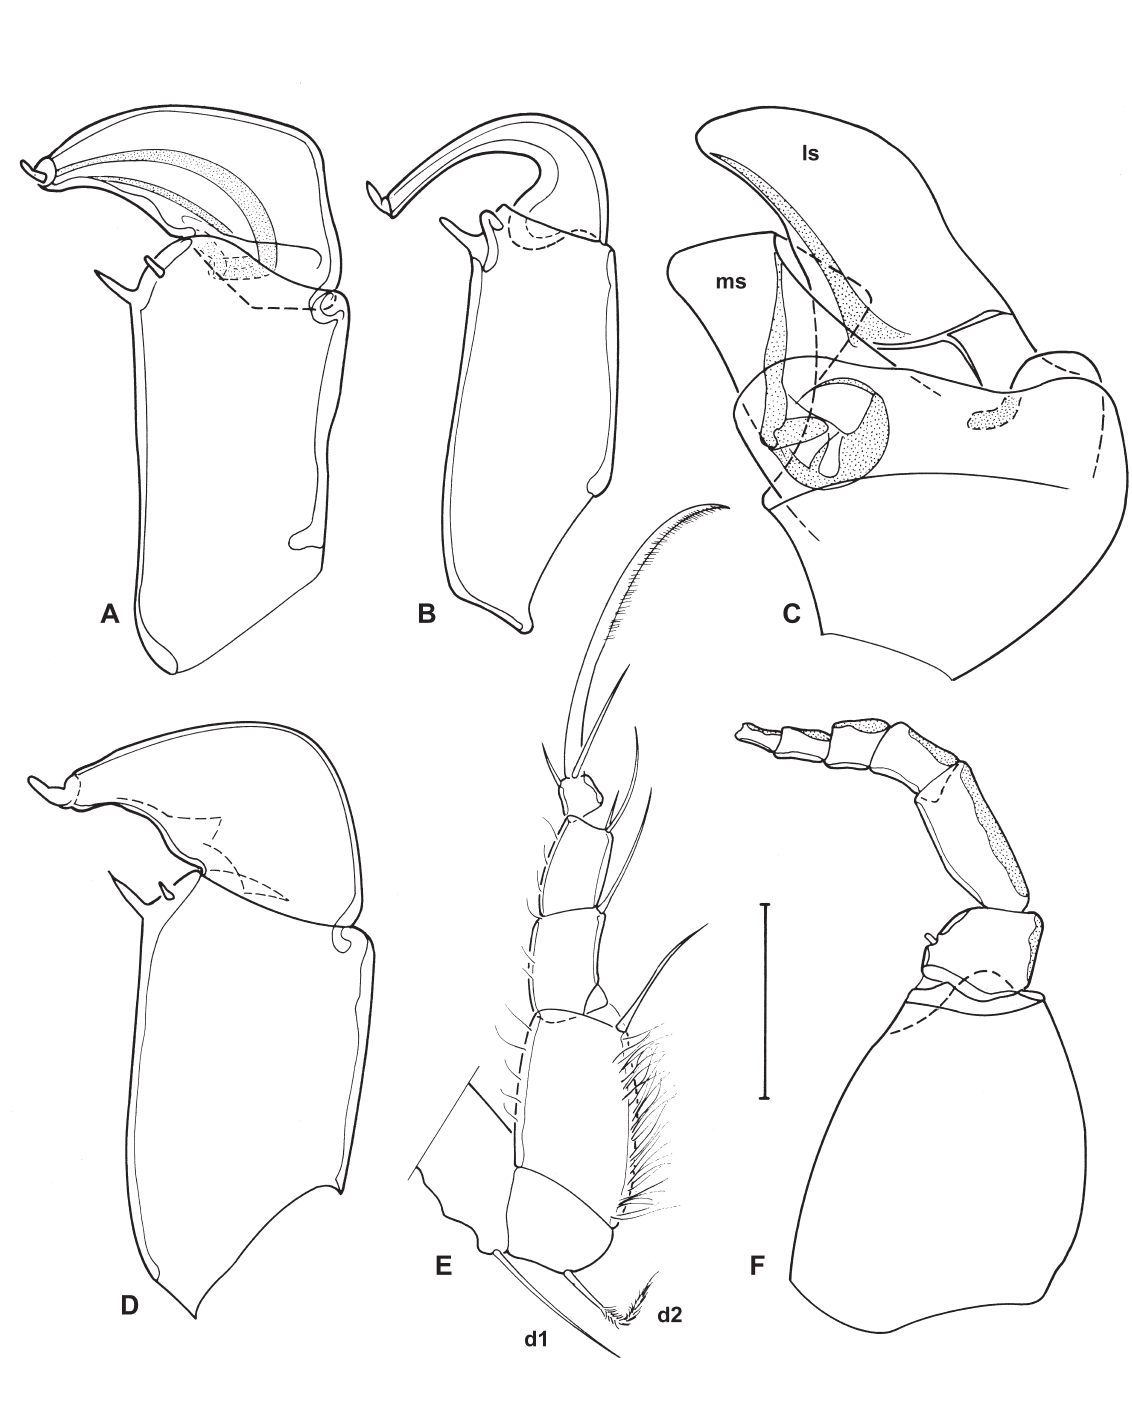
Fig. 24. A - C , E , F . Bennelongia kimberleyensis sp. nov. (♂, OC.3323, Parry’s Lagoon, Kimberley); D. B. strellyensis sp. nov. (♂, WAM.C49421, Strelley Station, Pilbara). A . right prehensile palp. B . Left prehensile palp. C . Hemipenis outline. E. T2. F . A1, without chaetotaxy, showing strongly sclerified dorsal margins of segments. D . right prehensile palp. Scales: C, E, F = 232 µm; A, B, D = 92